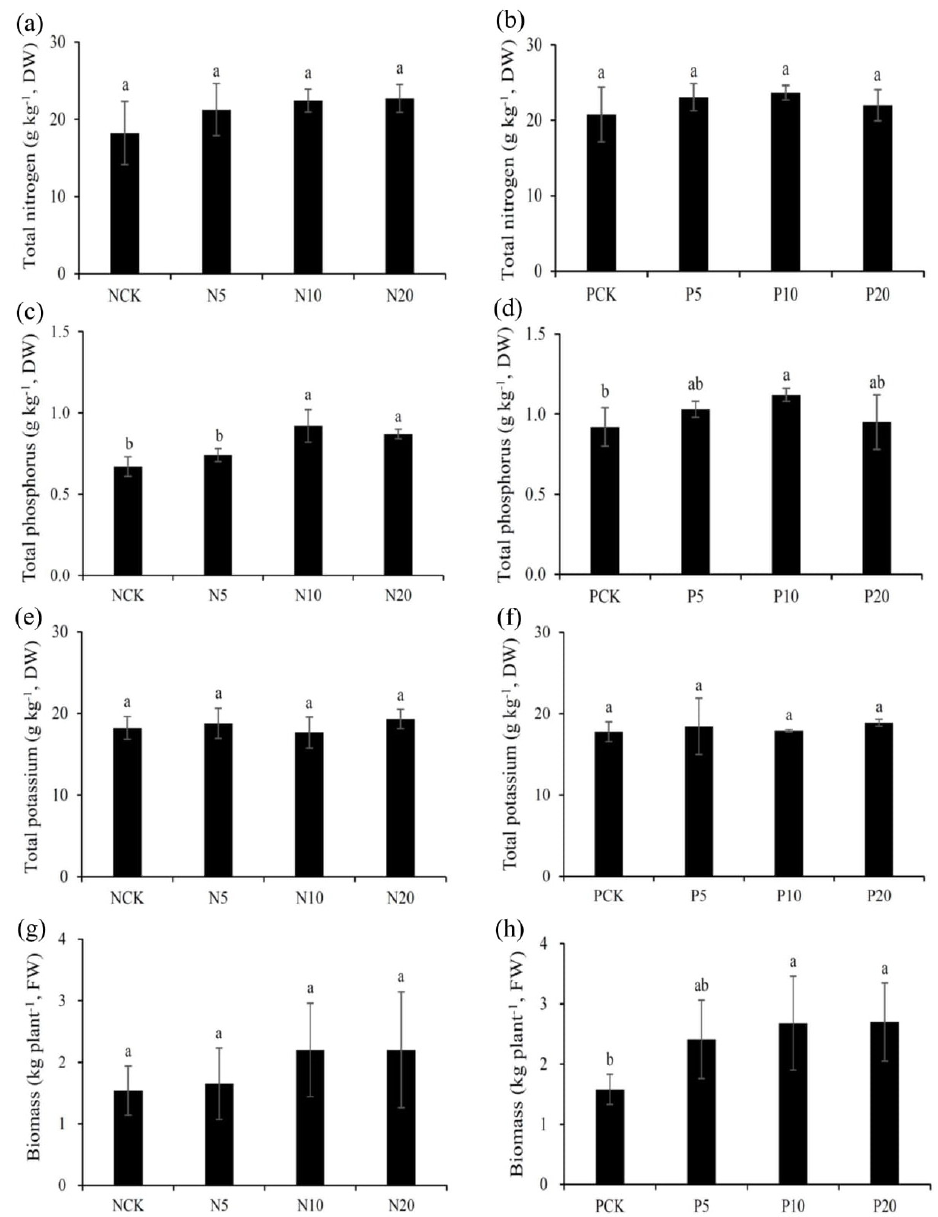
Figure 1. Effects of different fertilizer treatments on contents of total nitrogen, total phosphorous, total potassium, and biomass in shoots of V. negundo . ( a , b ) Total nitrogen; ( c , d ) total phosphorus; ( e , f ) total potassium; and ( g , h ) biomass. Error bars represent standard deviation ( n = 5), and bars with the same letter are not significantly different between treatments ( p < 0.05, Duncan’s multiple range tests). FW: fresh weight; DW: dry